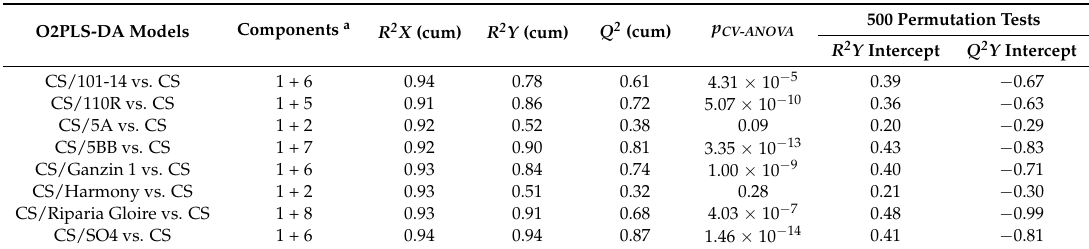
Table 3. Validation of O2PLS-DA models on volatile compounds in berries for the comparison of each grafted vine and own-rooted